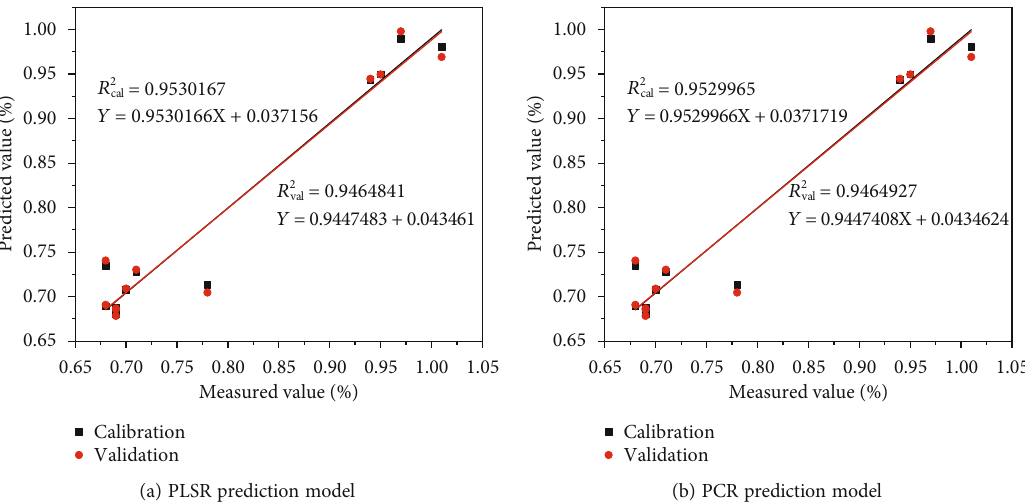
Figure 2: Correlation diagram between predicted values and measured values of PLSR and PCR prediction models for peak strain of frozen- thawed rocks.